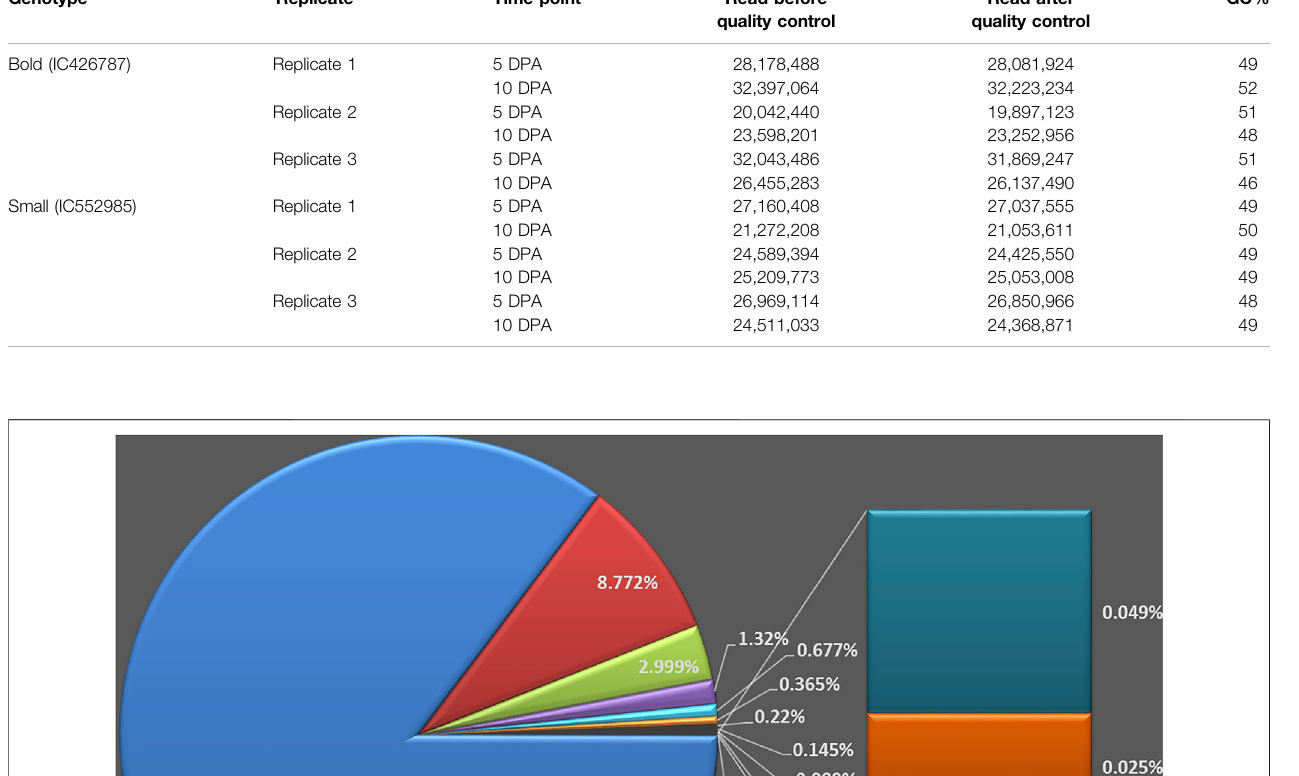
TABLE 1 | Summary of RNA-Seq data for 12 samples of ricebean at 5 DPA and 10 DPA. Genotype